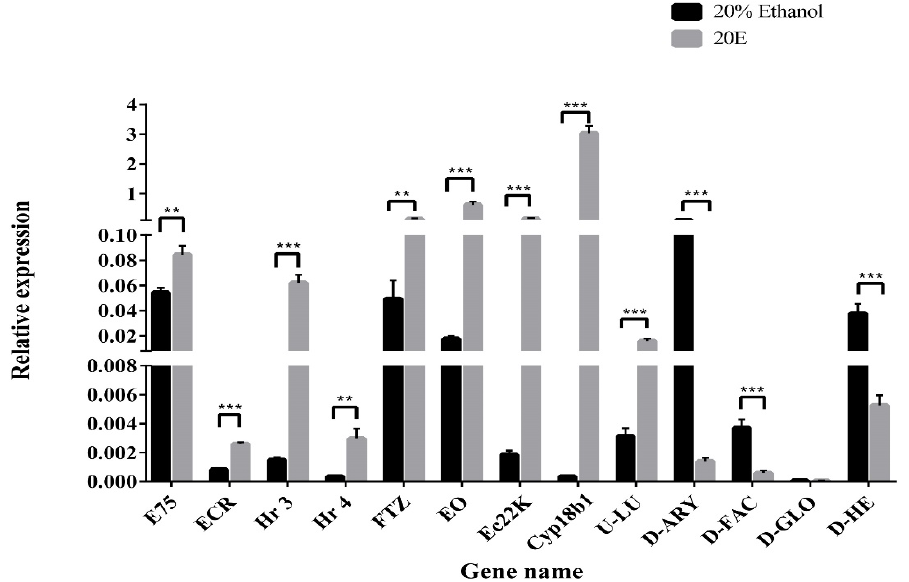
Figure 4. Quantitative real-time PCR validation of the differently expressed genes. Relative gene expression was calculated using the formula 2 − ∆∆ Ct and normalized against HQ012003.2 (GAPDH). Error bars represent the mean ± SD, from one experiment run in triplicate. Statistical significance was analyzed with unpaired Student’s t -test (** p < 0.01, and *** p < 0.001).